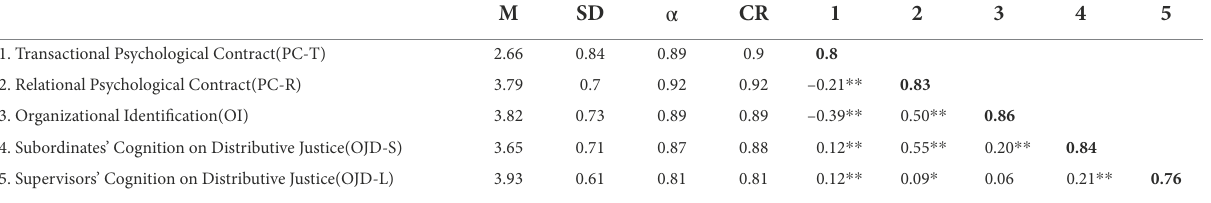
TABLE 3 Descriptive